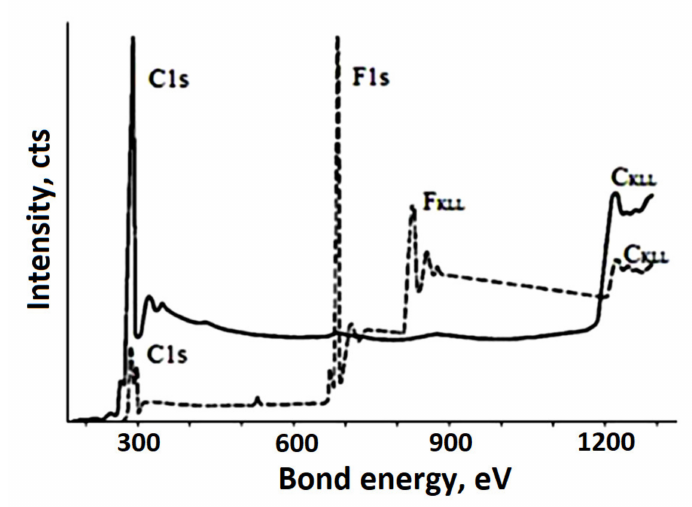
Figure 11. Panoramic photoelectron spectra of the original and dehydrofluorinated for 1 h at ~20 ◦ C PVDF film (dashed and solid lines, respectively) [106].